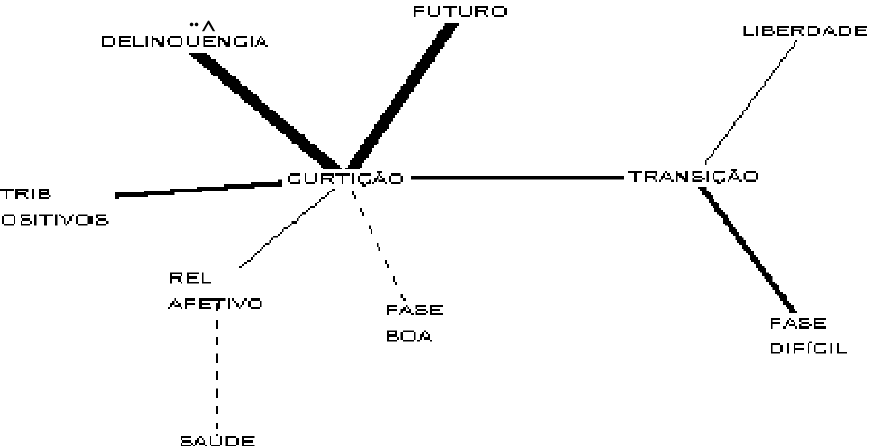
Figura 2. GrÆfico de anÆlise de similitude das categorias relacionadas (cid:224) adolescŒncia ( n =360).